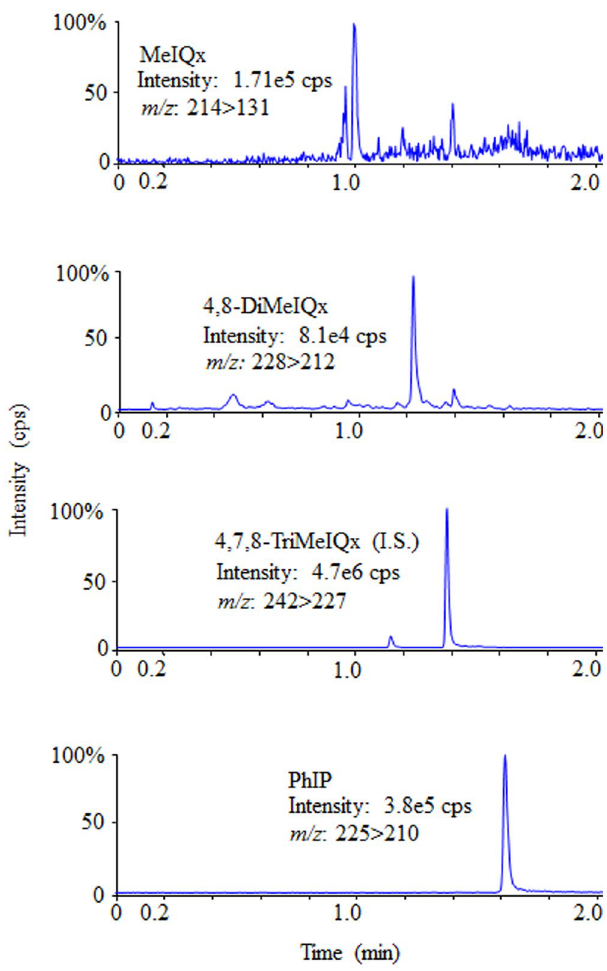
Figure 1. UPLC-MS/MS chromatograms of HCAs in home-cooked